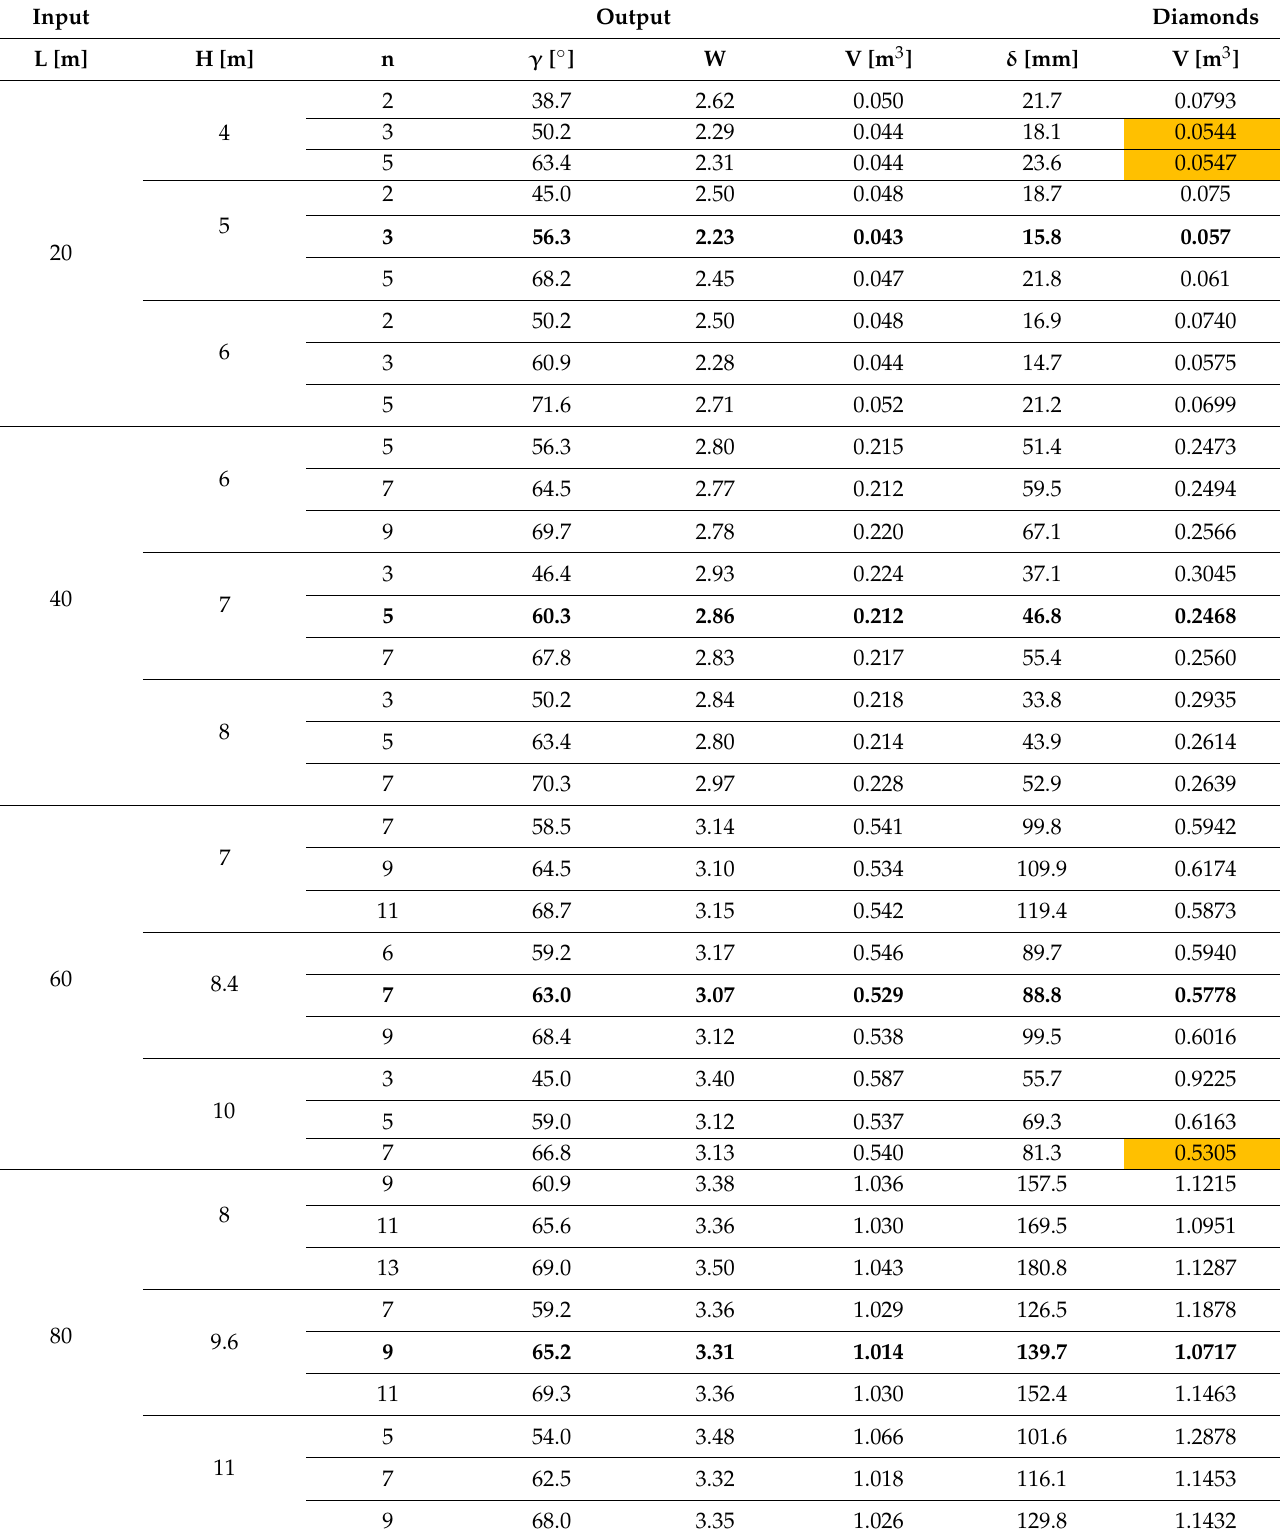
Table 1. Warren trusses (The most optimal result according to the software tool is indicated in bold, the results in Diamonds that deviate are highlighted in